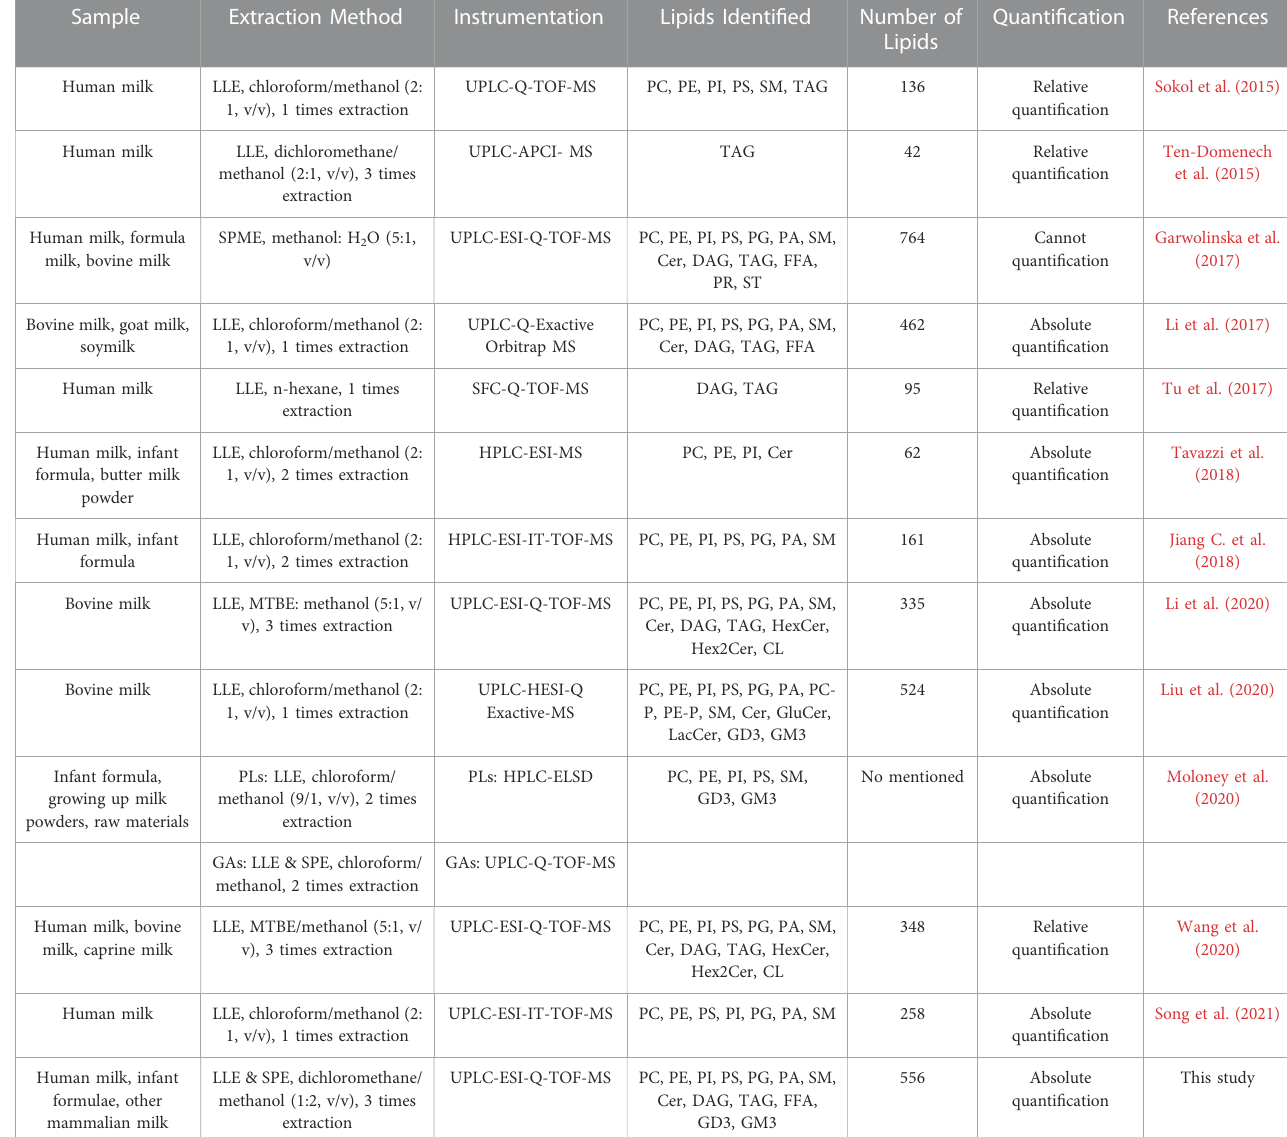
TABLE 6 Comparison of extraction and analytical methods used for lipids in milk and dairy products. Sample